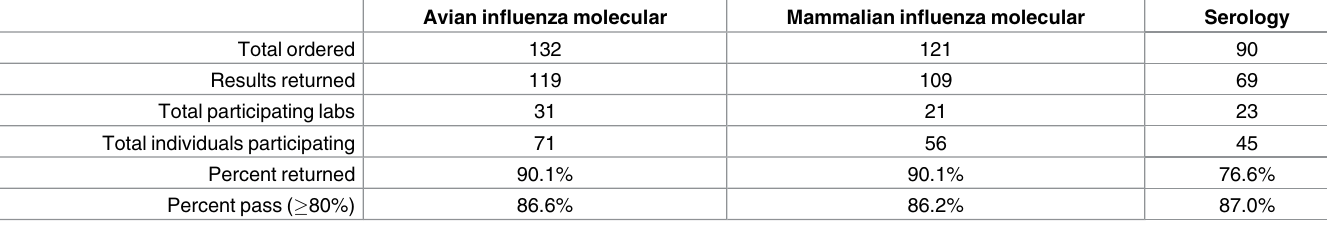
Table 1. Summary of external quality assurance sample ordering, completion and results